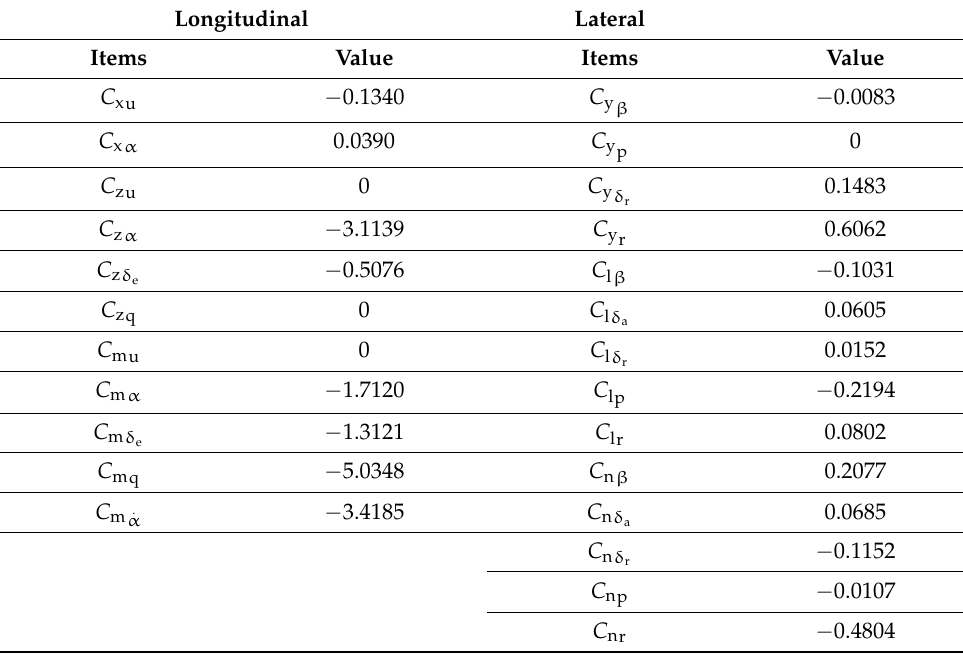
Table 2. Aerodynamic parameters of the one-third-scale Oowashi.